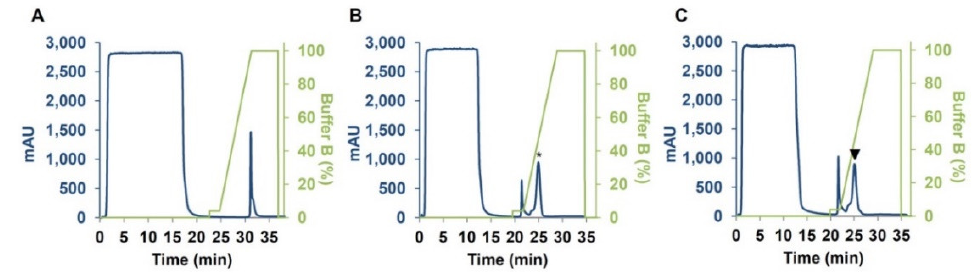
Figure 2. Chromatograms of CM3 ( A ), CM16 ( B ) and 0.28 ( C ) using HisTrap HP affinity column. Chromatograms indicate the Absorbance Units (at 280 nm) at each retention time (min) and following the elution buffer concentration. The peaks corresponding to CM16 and 0.28 proteins are indicated by an asterisk and a triangle, respectively. Buffer B is 50 mM Na-phosphate, 150 mM NaCl, 500 mM Imidazole, pH 7.5 .